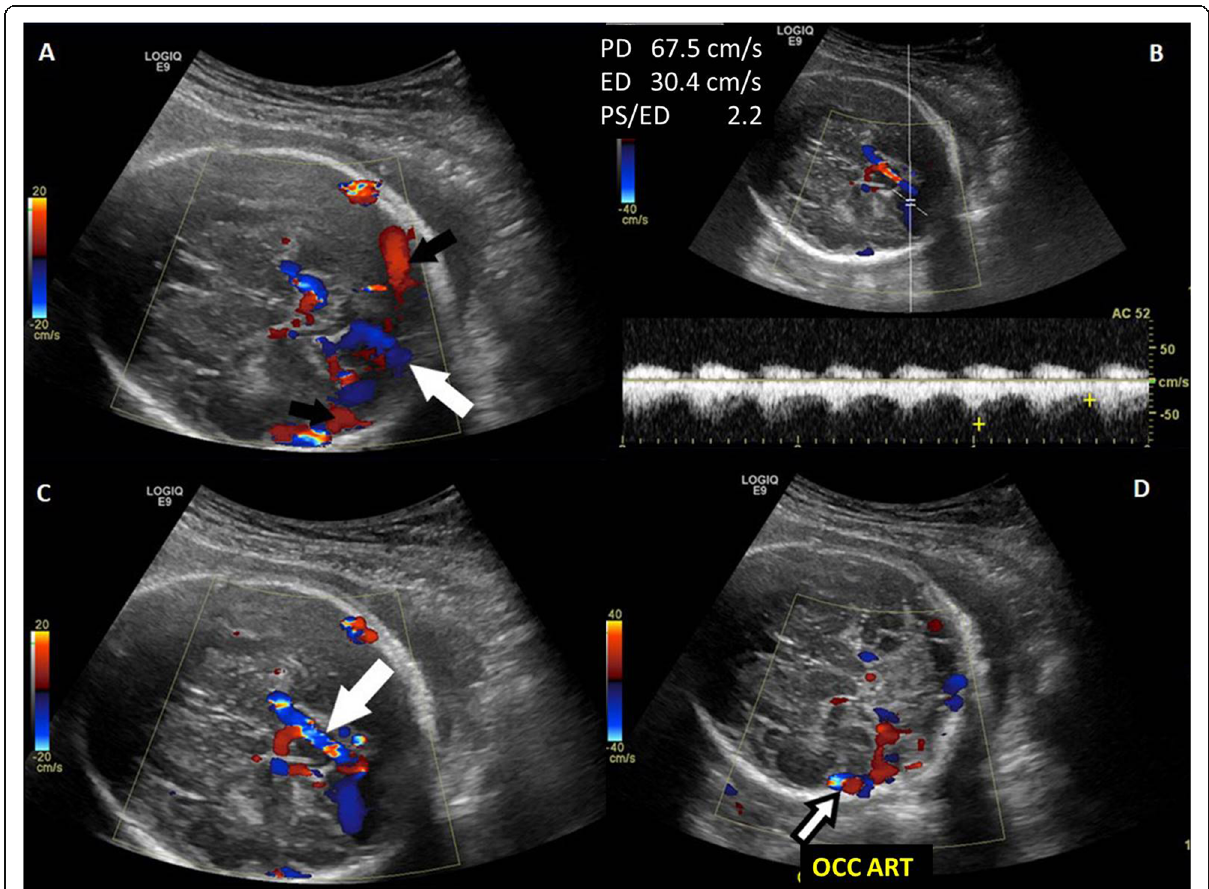
Fig. 3 Ultrasound at gestational age of 28 weeks 4 days — colour Doppler images of fetal brain: A Colour flow seen within dilated torcula (white arrow) and bilateral transverse sinuses (black arrows) with B arterialised flow seen within on spectral trace. C , D Blood supply to the torcula by posterior cerebral artery and occipital artery respectively